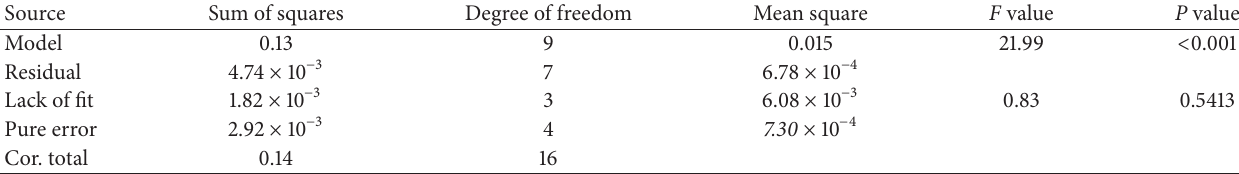
Table 3: ANOVA for fitted quadratic polynomial model of extraction of